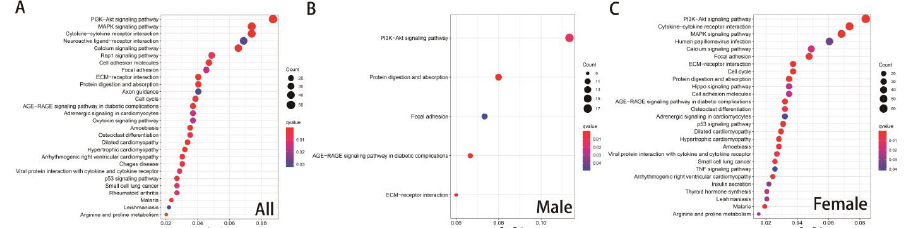
Figure 5. KEGG pathway enrichment in different sexes. ( A ) KEGG pathway enrichment of non- specific DEGs. ( B ) KEGG pathway enrichment of male-specific DEGs. ( C ) Gene ontology analysis of female-specific DEGs.